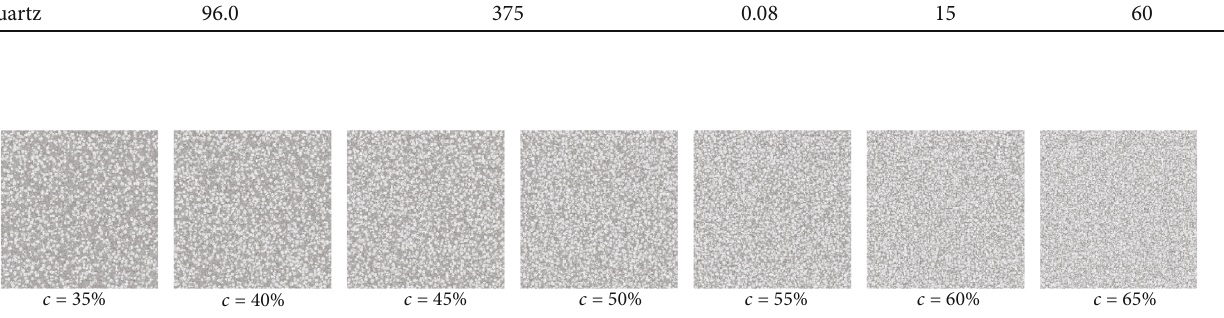
Figure 10: Numerical model of quartz- fi lled shale with di ff erent contents.